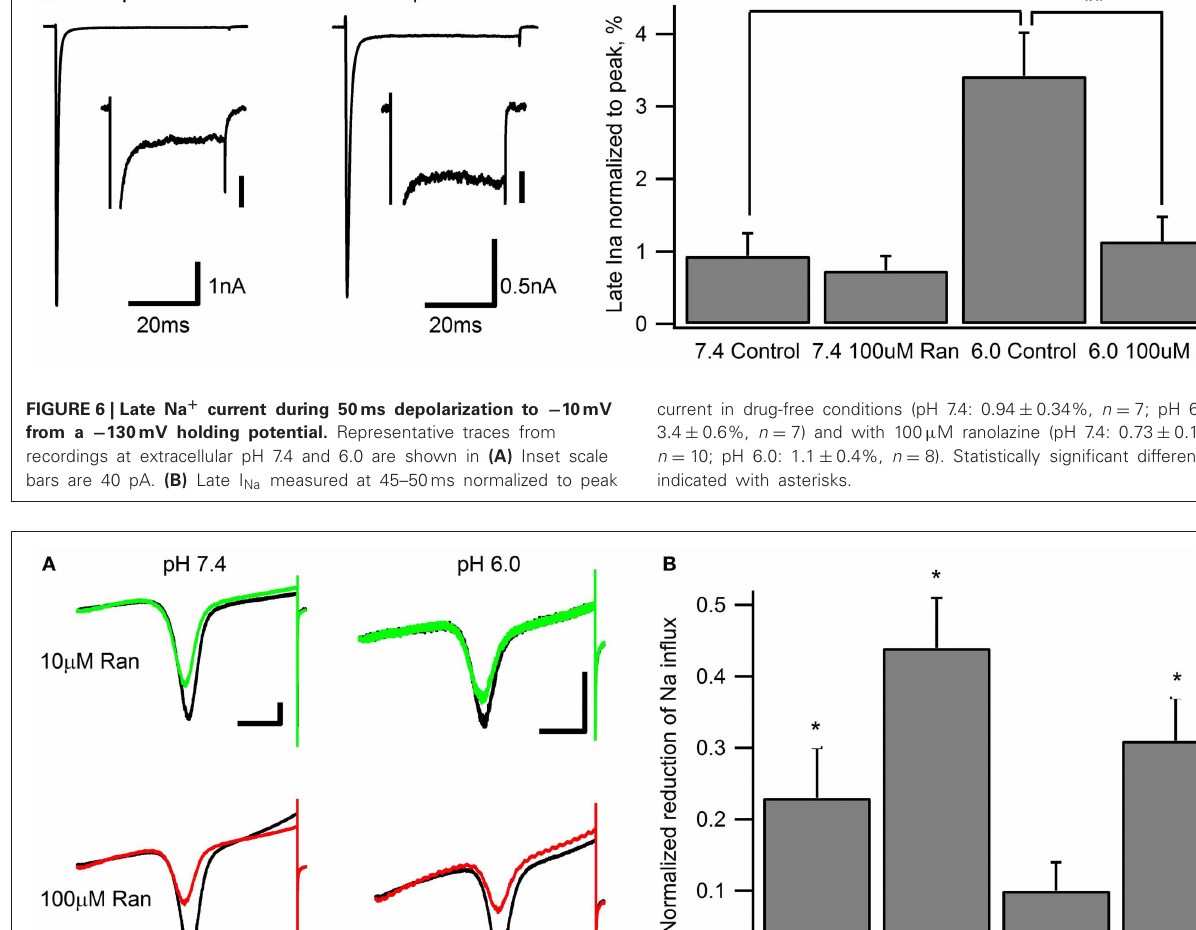
FIGURE 7 | Window currents measured with 500ms ramps (0.3mV/ms) from − 130 to + 20mV. (A) Representative matched pairs before and after perfusion of either 10 μ M ranolazine (top) or 100 μ M ranolazine (bottom). Scale bars are 100ms and 50 pA. (B) Total charge flow was calculated by